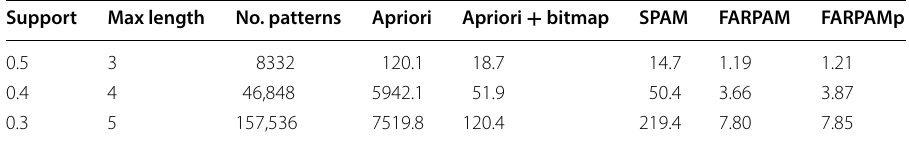
Table 3 Run times (in seconds) for algorithms with zero uncertainty β = 0 for the weather dataset (L3-D3-T14) measured over 14 places in the UK